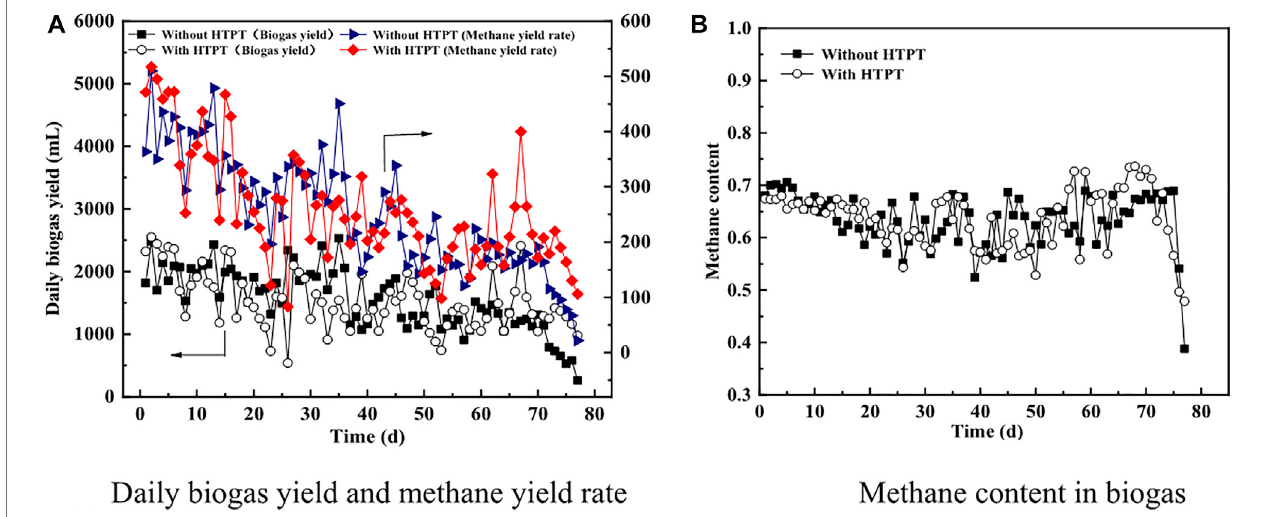
FIGURE 3 | Biogas production from continuous AD of tofu. (A) The daily biogas yield and the daily methane yield rate; (B) the methane content in biogas.